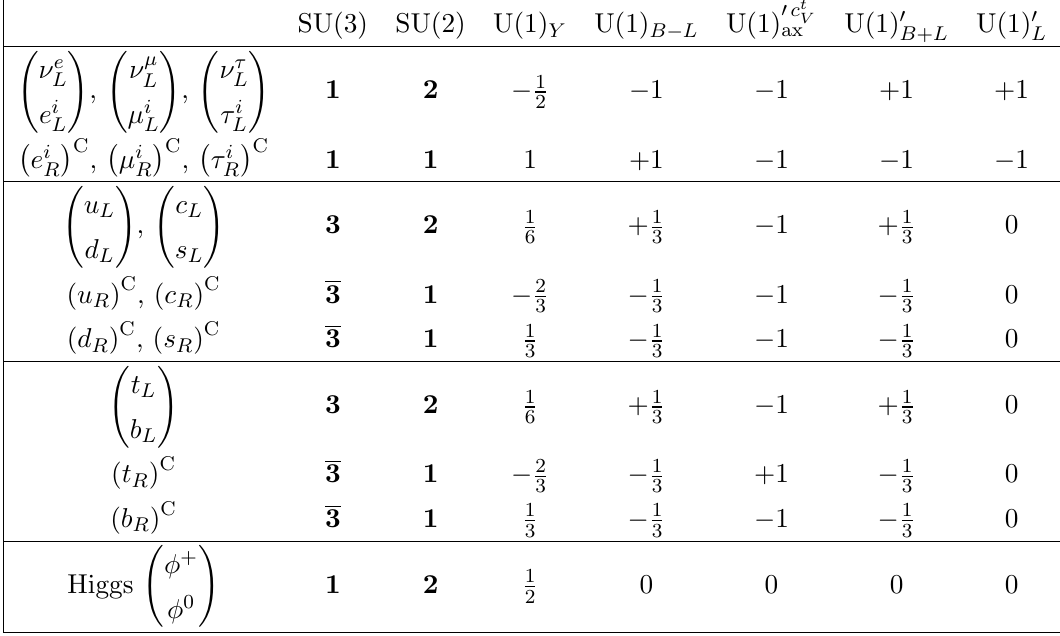
Table 1 . Charges of the SM matter content under some choices of U(1) 0 that we further analyze in the